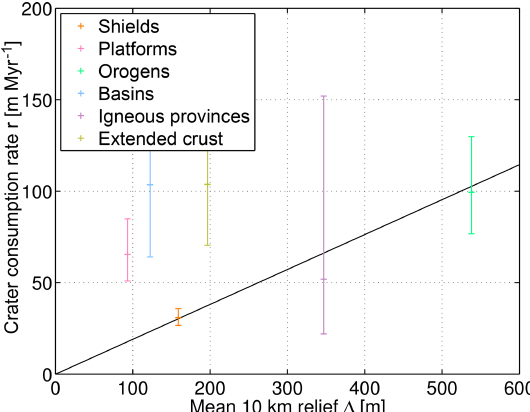
Figure 1. Rates of crater consumption derived from Eq. (2) vs. mean relief for the basic types of continental crust (http:// earthquake.usgs.gov/data/crust/type.html). The error bars represent 70% confidence intervals corresponding to the standard deviation for a Gaussian distribution.